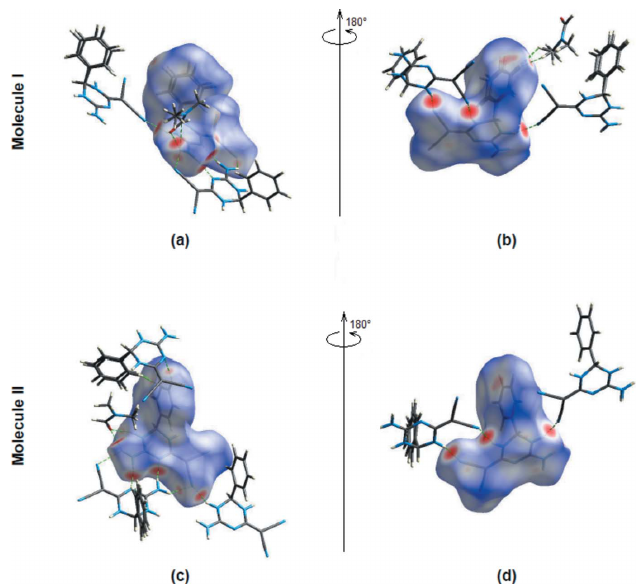
Figure 7 Front and back views of the three-dimensional Hirshfeld surfaces of molecules I ( a , b ) and II ( c , d ) of the title compound.